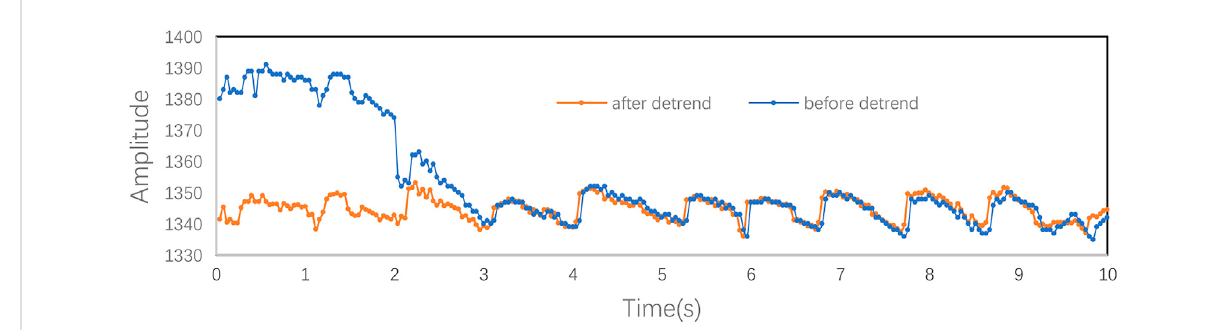
FIGURE 4 Comparison between before and after signal detrend.